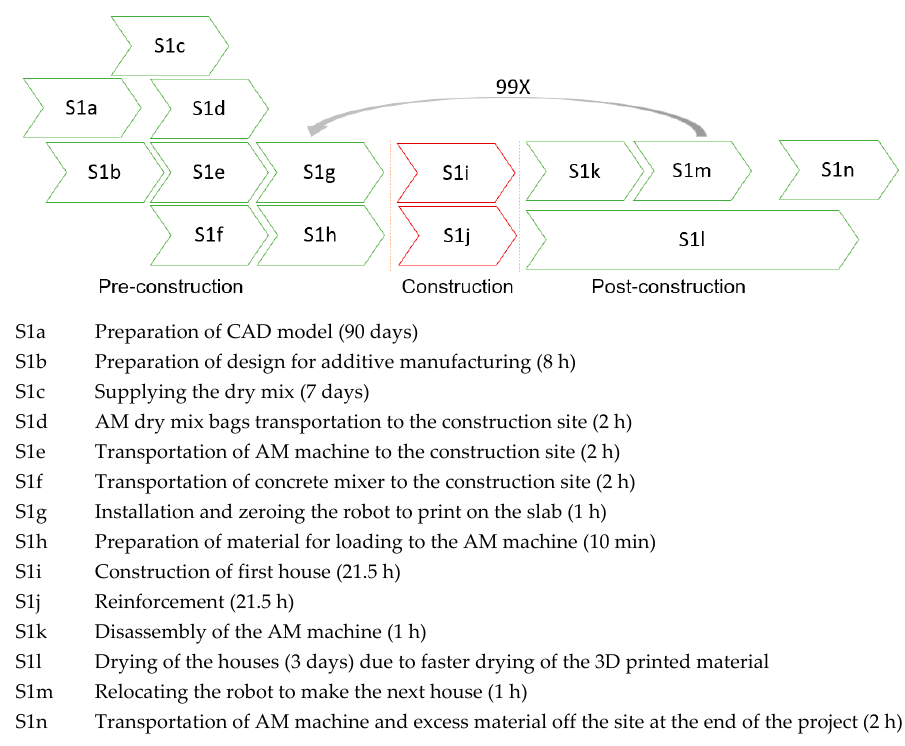
Figure 3. The process map for Scenario 1.